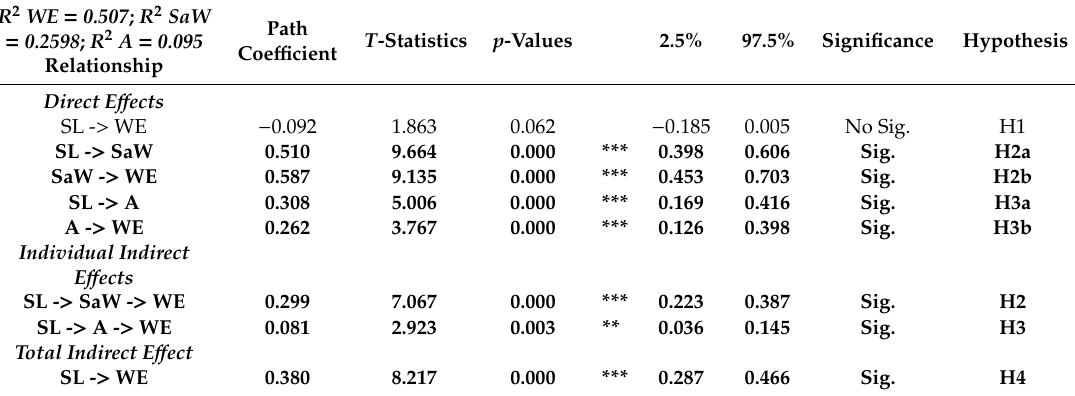
Table 5. Structural